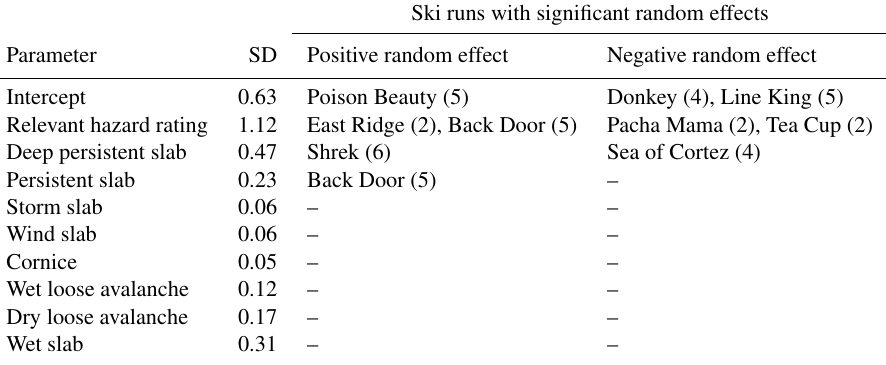
Table 6. Variance of by-run random effects expressed as standard deviations. In addition, ski runs with significant positive or negative random effects are listed. The number in brackets indicates the ski run